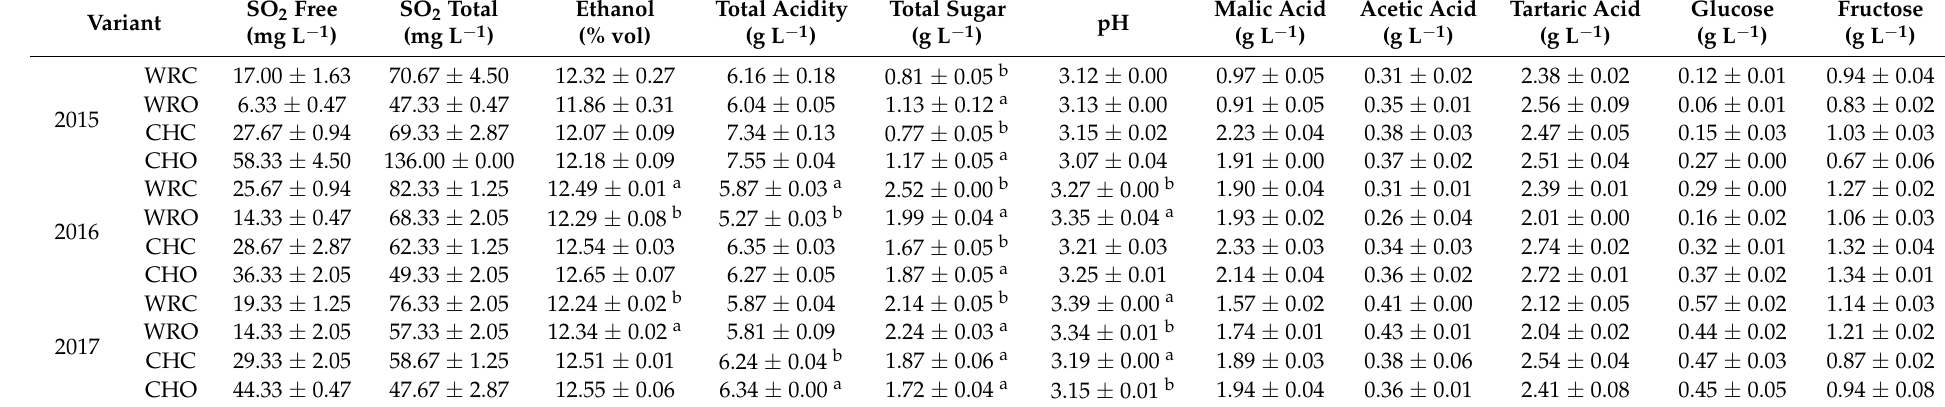
Table 1. Basic physical and chemical parameters of the wine variants in experimental years 2015, 2016, and